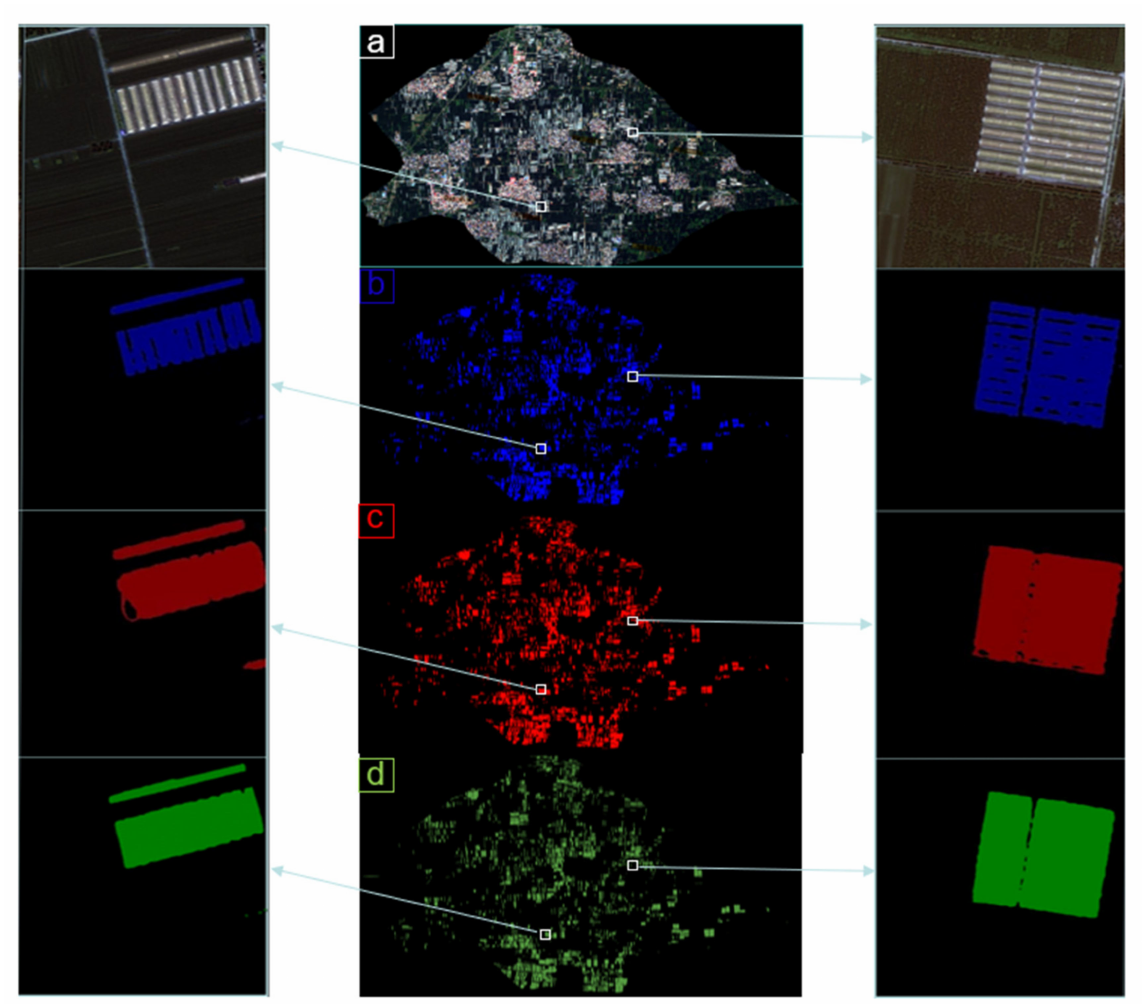
Figure 10. Greenhouse segmentation results of different network structures ( a ): Ground Truth ( b ): UNet ( c ): ENVINET5 ( d ):